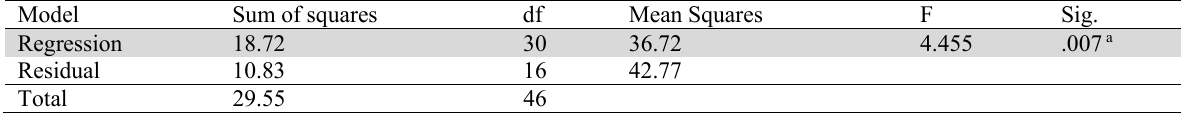
The summary of ANOVA